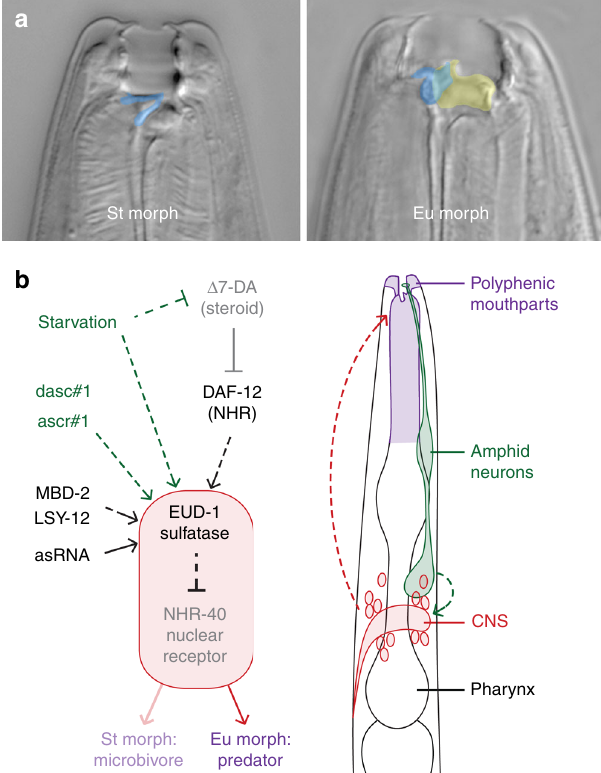
Fig. 1 Developmental regulation of polyphenism in Pristionchus paci fi cus